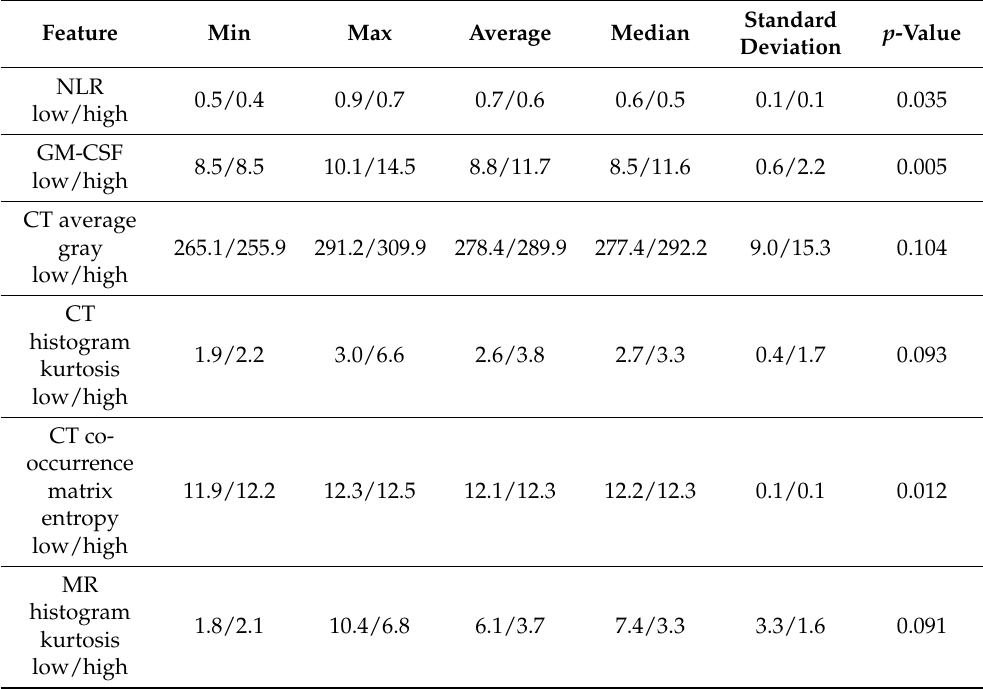
Table 4. Descriptive statistics on significant blood counts, blood cytokines, and radiomics used in model building. The low/high notation denotes where the corresponding number is from the low or high inflammation group, based on the observed CD45 from Table 1. The last column outlines the calculated ANOVA p -value of the